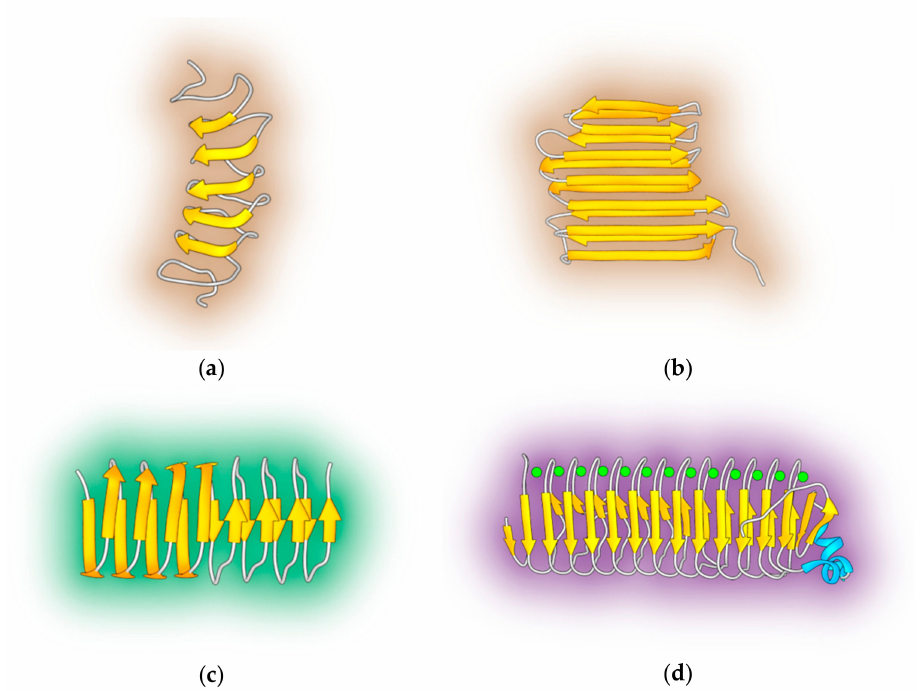
Figure 2. Overview of several AFPs with β -helix secondary structure. ( a ) Tm AFP (PDB:1L1I); ( b ) the insect protein Ri AFP (PDB:4DT5); ( c ) the ryegrass lp AFP (PDB:3ULT), and ( d ) the calcium-dependent Antarctic bacteria antifreeze protein Mp AFP